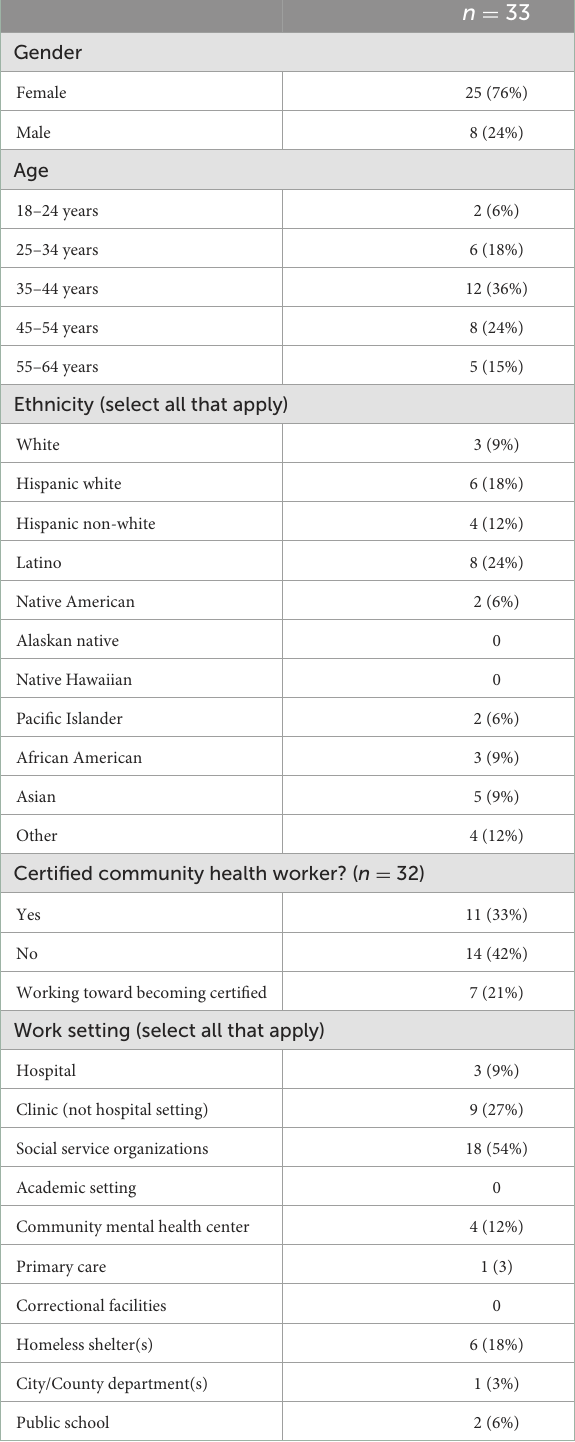
TABLE 1 Community health worker demographic